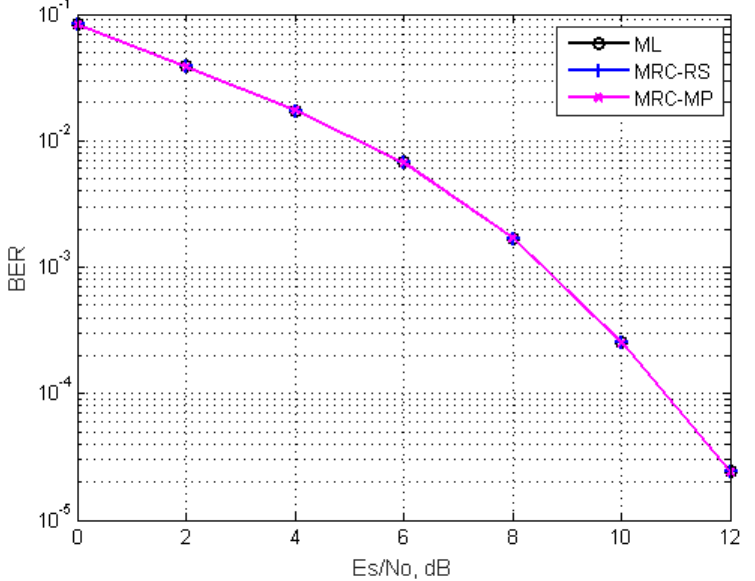
Figure 8. BER performance comparison of the proposed detectors with ML detector for GSM system with N t = 16, N r = 16, M = 16 and N p =